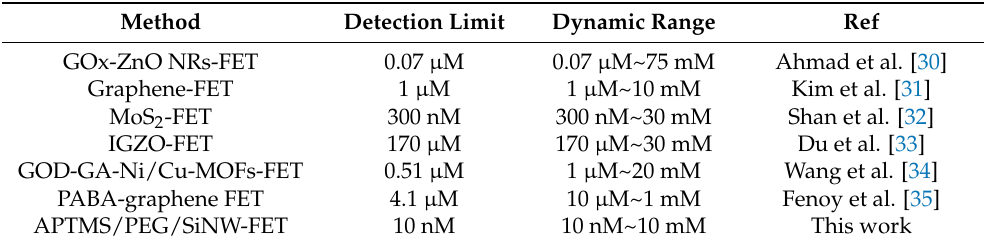
Figure 5. ( a ) Real − time response curve of glucose concentration in the range of 10 nM~10 mM for APTMS/PEG/SiNW − FET sensor when V G = − 3 V, V DS = 2 V. ( b ) Calibration chart of steady − state current and glucose concentration, the relationship between current change and glucose concentration and its linear fitting curve, the fitted linear relationship is y = 2.01 + 0.47x, and the linear correlation coefficient (R 2 ) is 0.99747. Table 1. Performance of PEG and GOD co-modified SiNW-FET glucose biosensors compared to other FET-based glucose